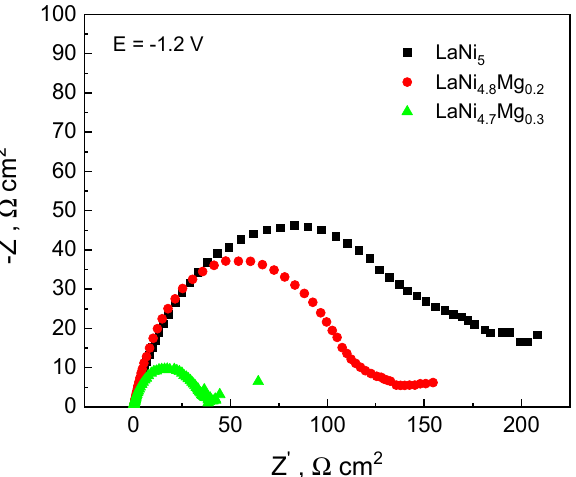
Figure 6. Electrochemical impedance spectra of the LaNi 5-x Mg x electrodes obtained at a potential of − 1.2V. Experimental conditions: 6M KOH, 25 °C, frequency range of 100 kHz to 10 MHz, amplitude of 5 mV.